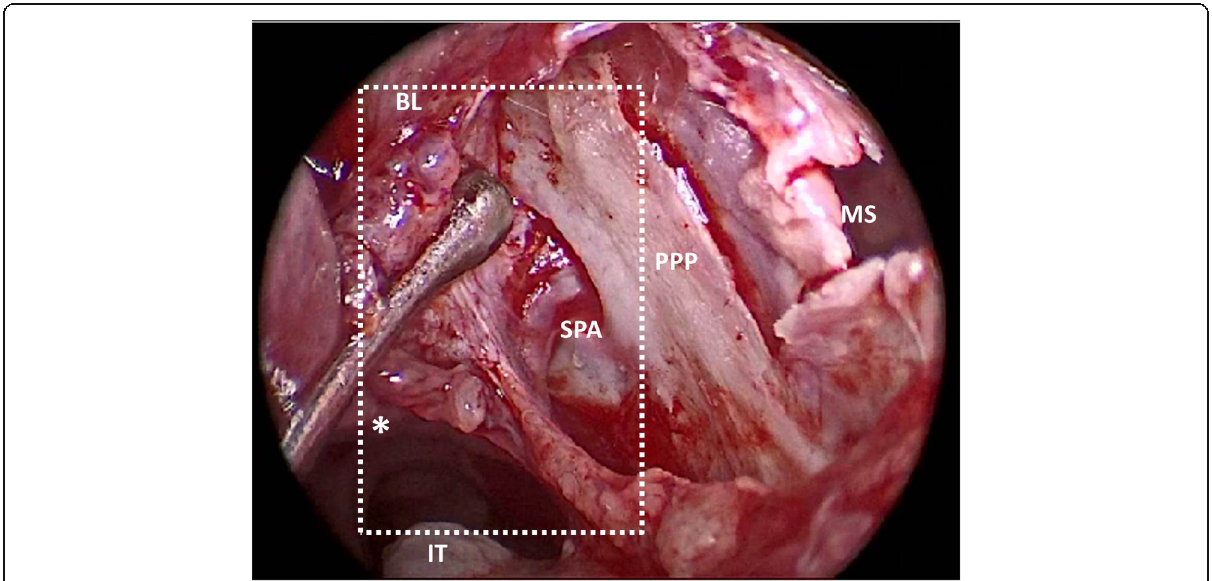
Fig. 1 Picture of a left nasal cavity showing details of the target area on the lateral nasal wall for identification of SPA. In the superior border, the posterior medial maxillary wall. The posterior end of the middle turbinate (*) is the inferior border. The junction between the basal lamella and perpendicular plate of palatine bone is the posterior border. In the anterior border, the superior edge of the inferior turbinate. BL basal lamella, SPA sphenopalatine artery, PPP perpendicular plate of the palatine bone, IT inferior turbinate, MS maxillary